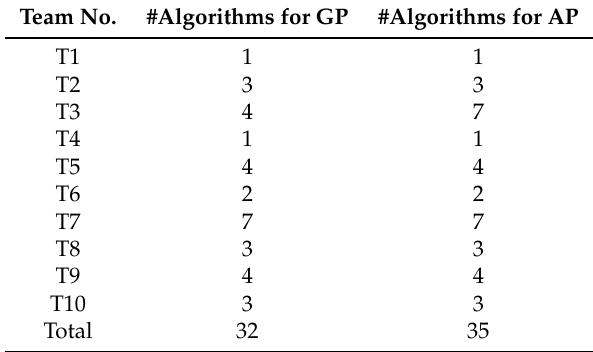
Table 2. Total number of submitted algorithms by different teams—for Gender Prediction (GP) as well as Age Prediction (AP).